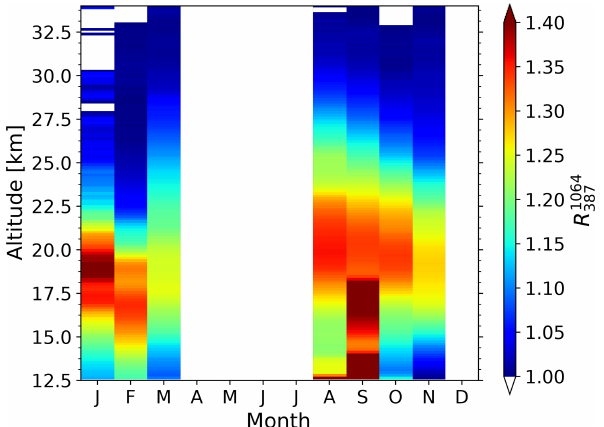
Figure 9. Monthly mean aerosol backscatter ratio R 1064 measurement runs from 2014 to 2017. The dataset contains only nighttime measurements and includes a total of 1255h.